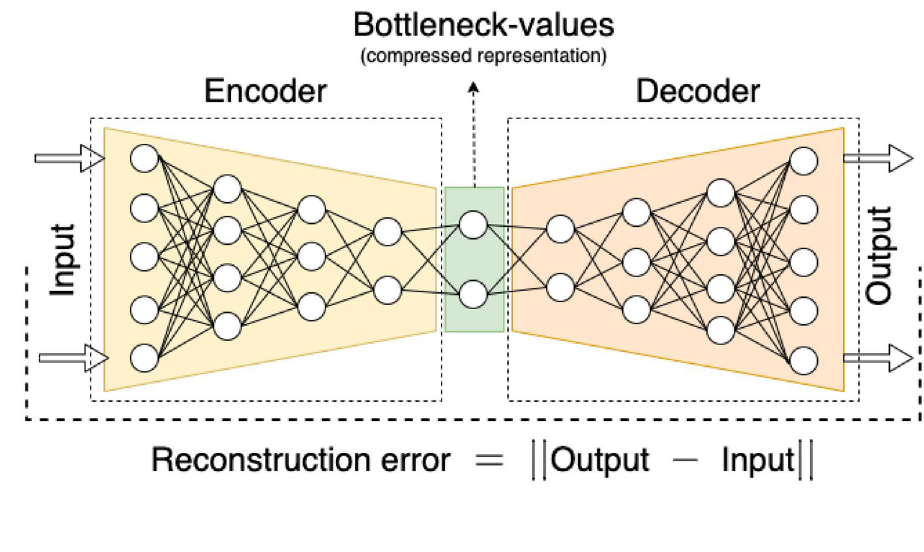
Fig. 1 Basic autoencoder